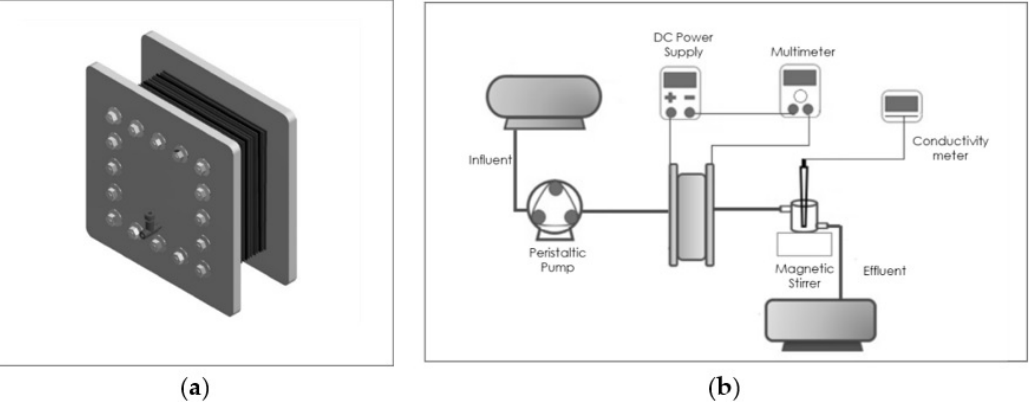
Figure 1. ( a ) CDI Cell structure with the electrode pairs in ( b ) schematic CDI system in which the different elements (CDI cell, peristaltic pump, DC power supply, conductivity and pH meter) are displayed.